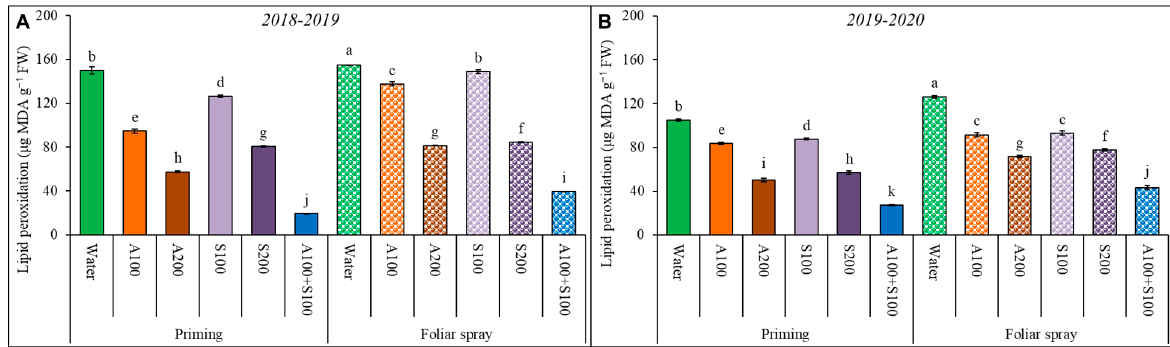
Figure 5. Lipid peroxidation in wheat affected by AA and SA treatments at 80 DAS during the two winter seasons ( A ) 2018/2019 and ( B ) 2019/2020. Data are mean ± standard error ( n = 4). Letters represent significant differences between treatments at p < 0.05 level according to LSD test.